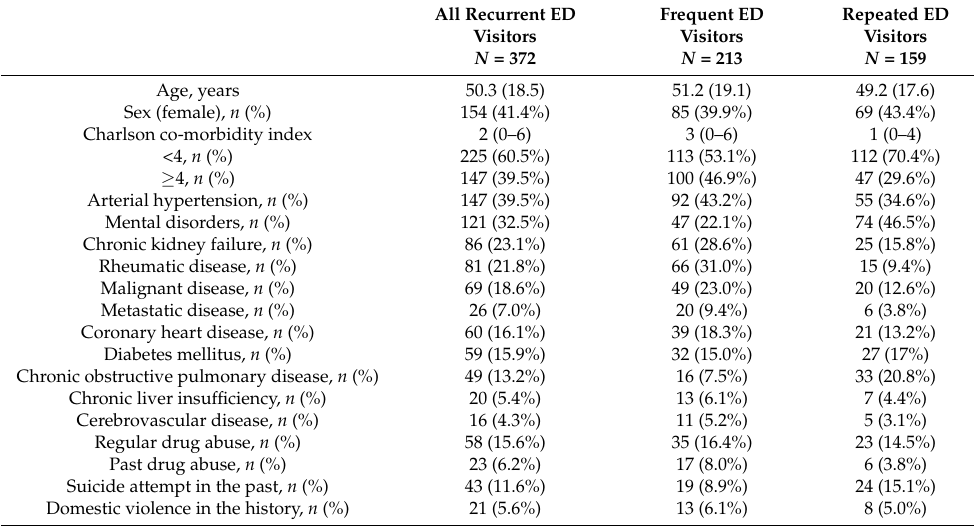
Table 1. Characteristics and co-morbidities of the recurrent emergency department (ED)